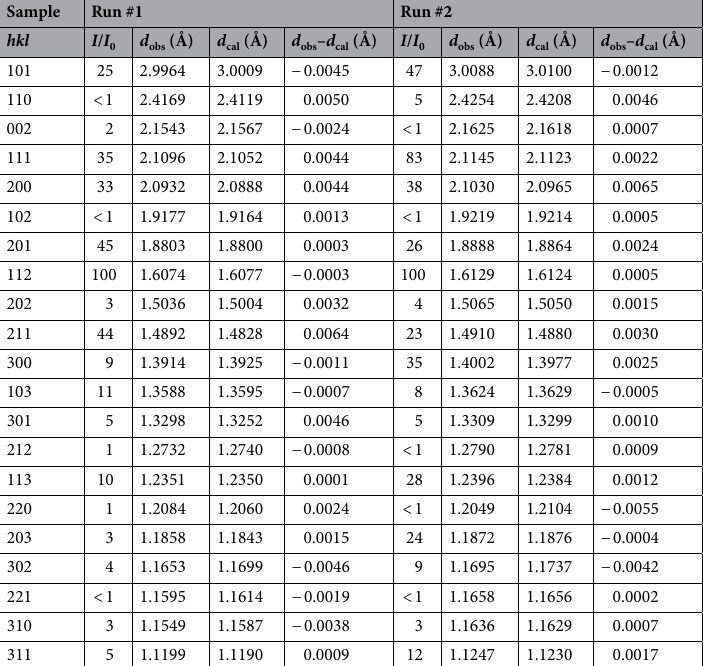
Table 2. Microfocus X-ray diffraction data for Al-phase D in the recovered samples of the runs #1 and #2. Calculated unit-cell parameters and volumes: a = 4.8239(1) Å, c = 4.3134(2) Å, V = 86.924(4) Å 3 for the run #1; a = 4.8416(1) Å, c = 4.3236(2) Å, V = 87.771(4) Å 3 for the run